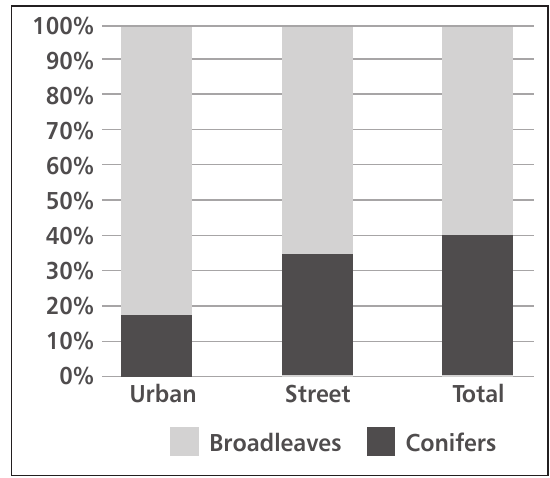
Distribution of urban and street woody plants by division